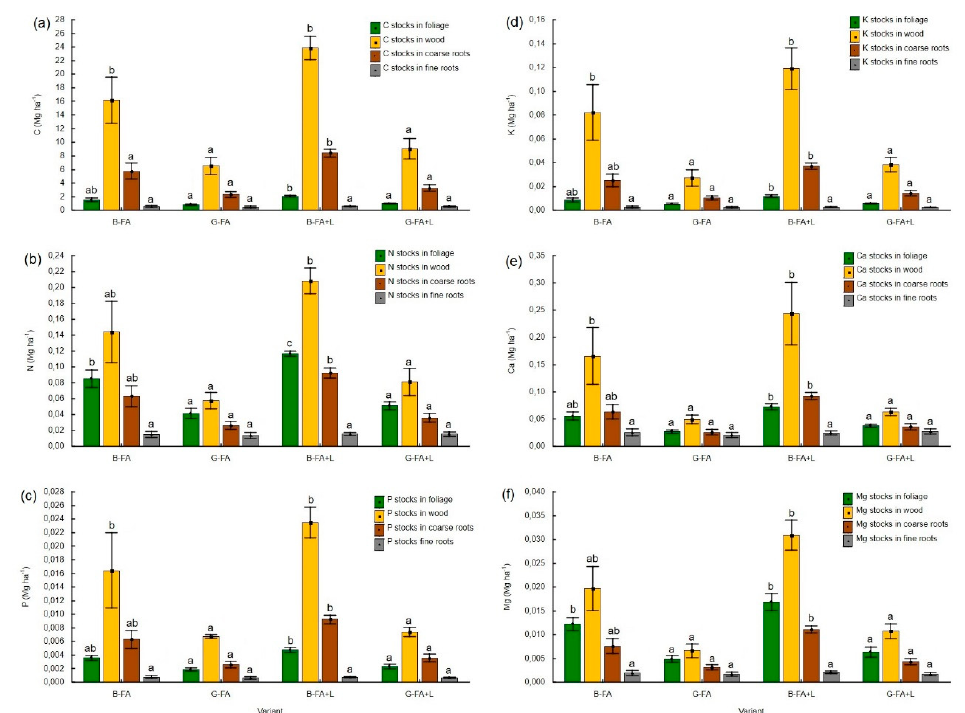
Figure 4. Nutrient stocks in biomass components of alder species grown on combustion waste landfill: